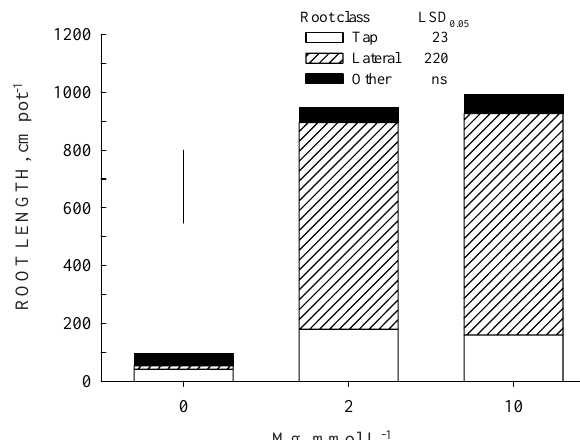
Figure 3. Total soybean root length and length of individual root classes at harvest in subsurface solution Mg treatments which received 15 µmol L -1 Al in Experiment 1. Root length is averaged across solution Ca levels and genotypes N93-S-179 (N93) and Young. Least significant difference values are for the main effects of Mg on individual root classes and total root length (vertical line); ns stands for non significant at p <